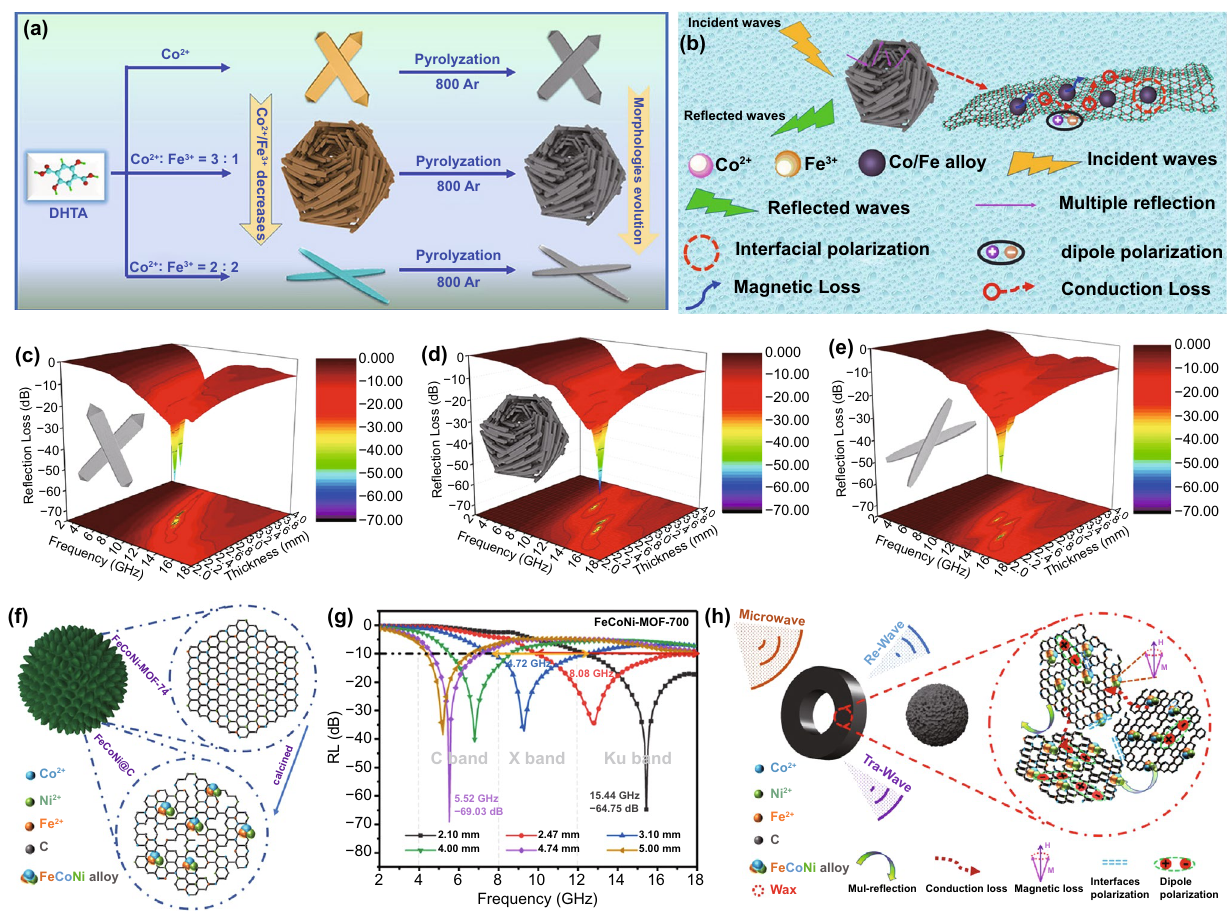
Fig. 9 Schematic illustration of a preparation process and b MA mechanism for CoFe@C composites with rod-like, nest-like and sheet-like structures. c–e 3D RL-f curves of three kinds of CoFe@C composites. Reprinted with permission from Ref. [122]. f Schematic illustration of preparation process, g RL-f curves and h MA mechanism of hollow FeCoNi@C nanocomposites. Reprinted with permission from Ref.